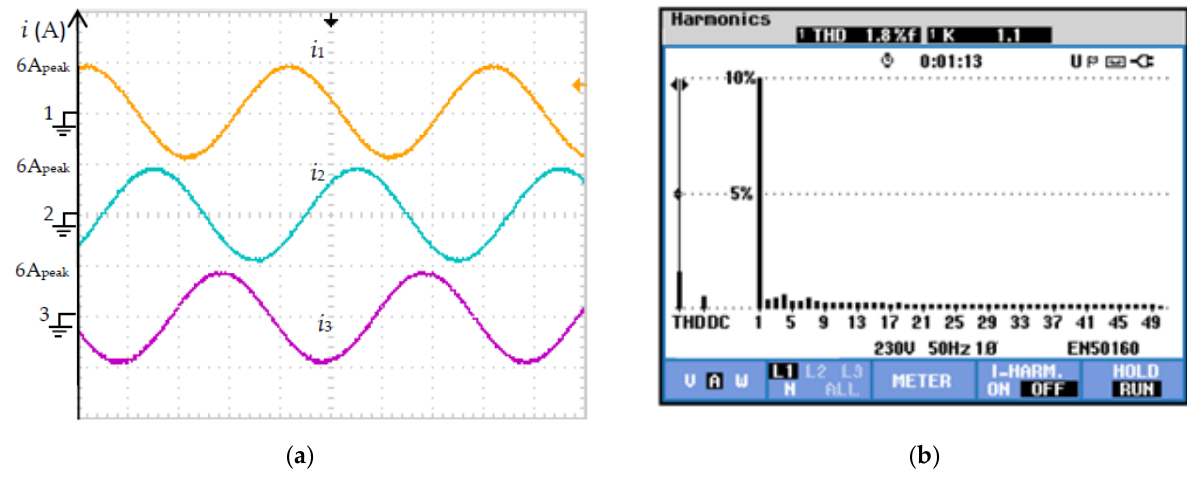
Figure 11. ( a ) Experimental results of AC currents, i 1 , i 1 , and i 3 , Vertical: 6 A/div. Horizontal: 5 ms/div. ( b ) Experimental result of AC current, i 1 , THD.